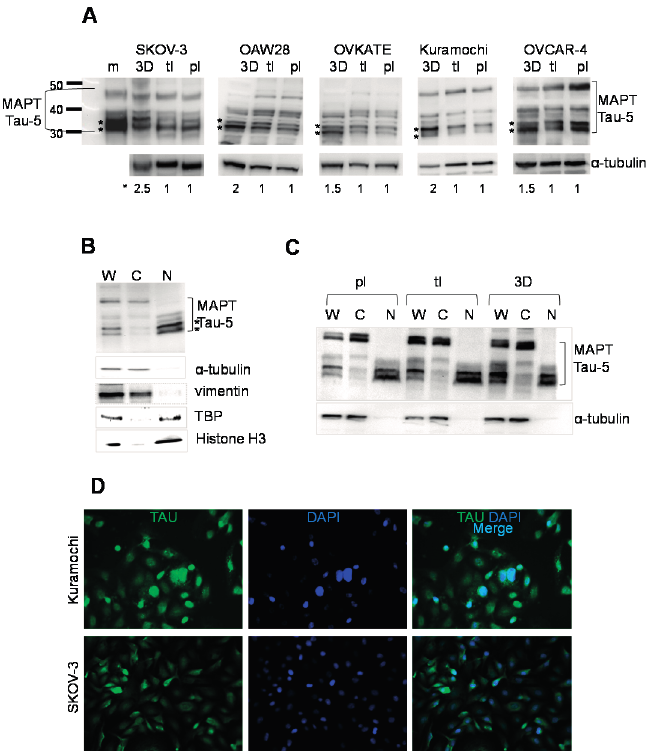
Figure 2. Expression of tau in cell culture models of serous ovarian carcinoma. ( A ) Expression of tau ( top panels ) in the cell culture models of ovarian carcinoma, as indicated, cultured in the indicated conditions was determined using Western blot. Positive control for tau “m” was used to determine positioning of the tau isoforms. Two lower molecular weight tau isoforms up-regulated when cells were cultured in three-dimensional collagen type I matrix (3DCIM) conditions are indicated with stars. α -Tubulin ( bottom panels ) was used as a loading control and to calculate normalized intensity of two lower molecular weight isoforms of tau (at the bottom of the gel images) using digital densitometry; ** indicate positions of the lower molecular weight tau isoforms; * indicates normalized tau as quantified by dividing the intensity corresponding to all tau isoforms by that corresponding to α -tubulin. ( B ) A representative Western blot image showing tau localization in the whole cell lysate (W), as well as its cytoplasmic (C) and nuclear (N) fractions of the tested serous ovarian carcinoma cell lines cultured on 3DCIM, as described in the Methods. Asterisks show positions of two lower molecular weight tau isoforms. α -Tubulin and vimentin were used as loading control for the cytoplasmic protein fraction, and tata binding protein (TBP) and histone H3 were used as loading controls for the nuclear protein fraction; ( C ) A representative Western blot image showing tau localization in the whole cell lysate (W), as well as its cytoplasmic (C) and nuclear (N) fractions of the tested serous ovarian carcinoma cell lines cultured on plastic supports (pl), type I (tl), and 3DCIM, as described in the Methods. α -Tubulin was used as loading control for the cytoplasmic protein fraction; ( D ) Immunofluorescence images of tau expression in serous ovarian carcinoma cell lines, as indicated. Images were generated using a Zeiss fluorescence microscope and 20× objective lens. The fluorescence signal from tau staining (green) was overlaid with DAPI staining (blue) to generate a merged image (light